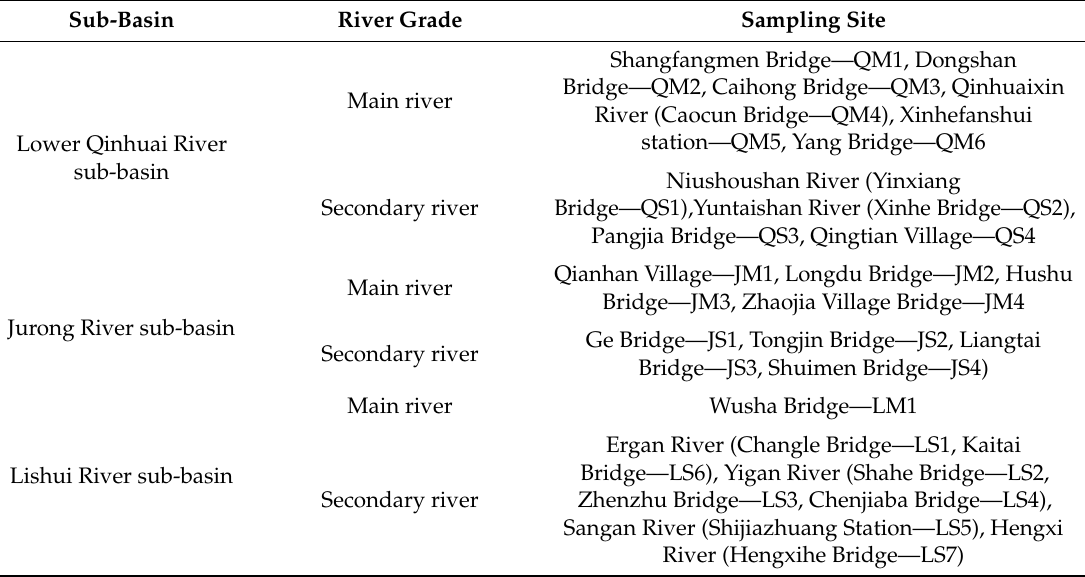
Figure 1. Location of the study area and sample sites in the Qinhuai River, East China. Table 1. Sub-basin and river grade of sampling